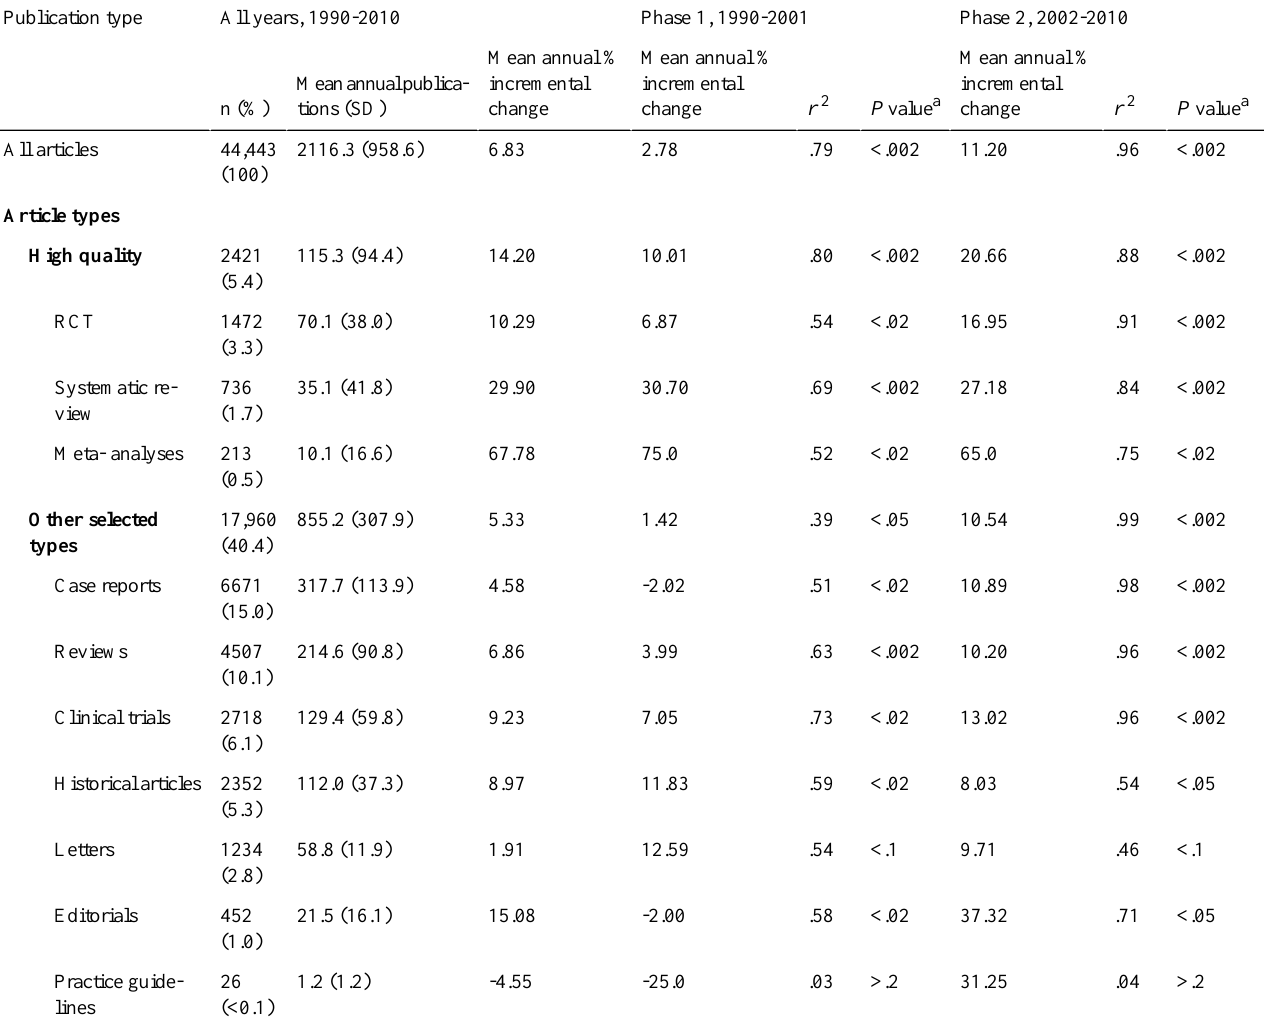
Table 1. The mean number of annual publications, mean annual incremental change and r 2 for the two time phases (1990-2001 and 2002-2010), and the overall study period, stratified by publication